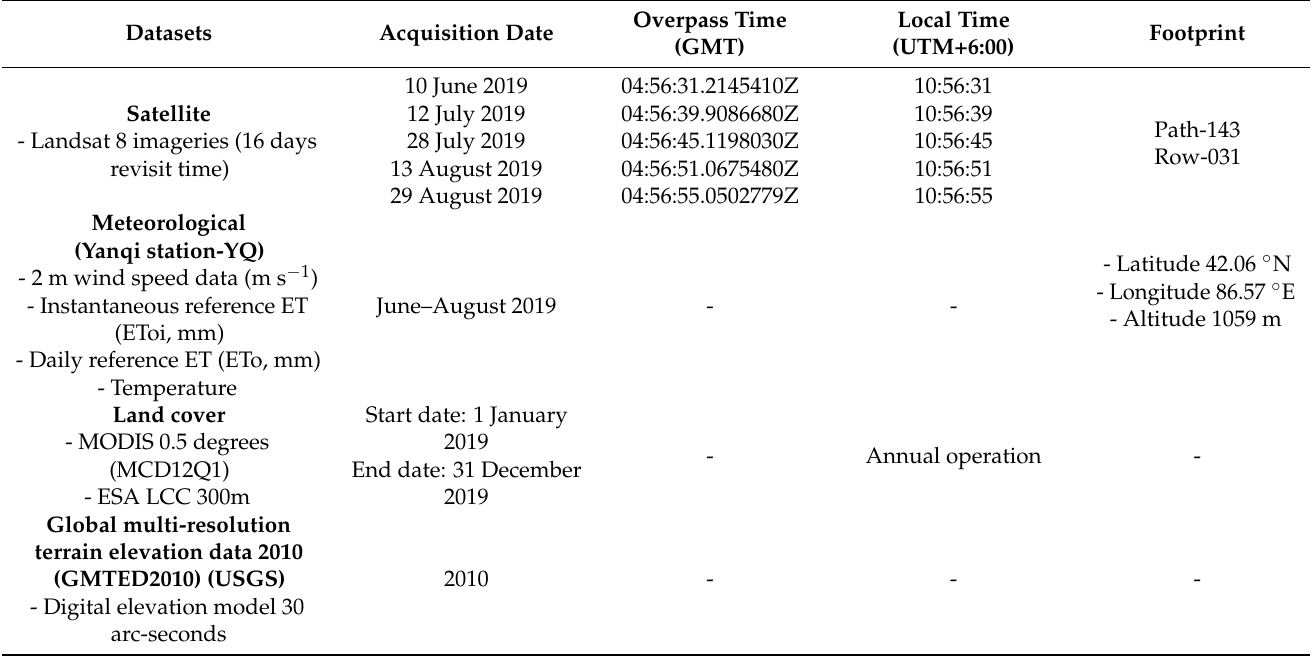
Table 1. Satellite products and ground-based observation datasets used in the